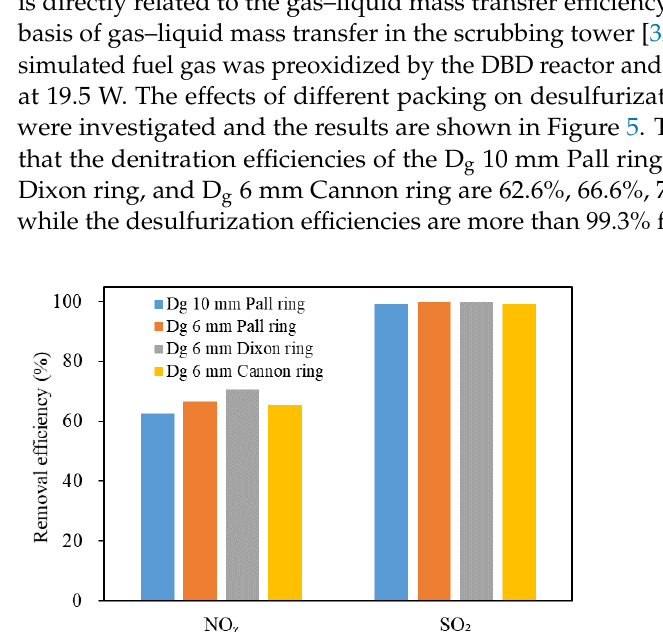
(cid:0) (cid:1) m 2 · h ,